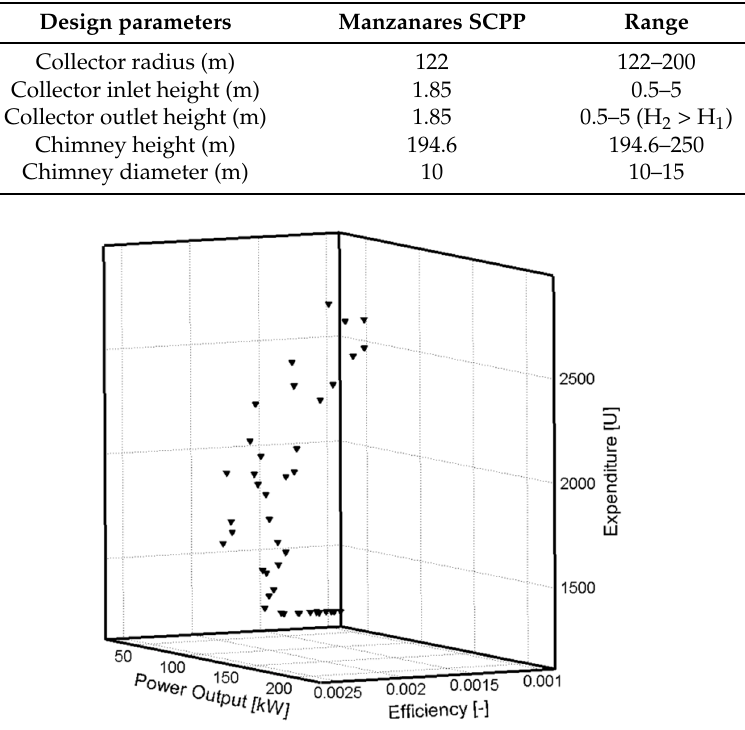
Figure 6. The Pareto front of the Manzanares power plant.